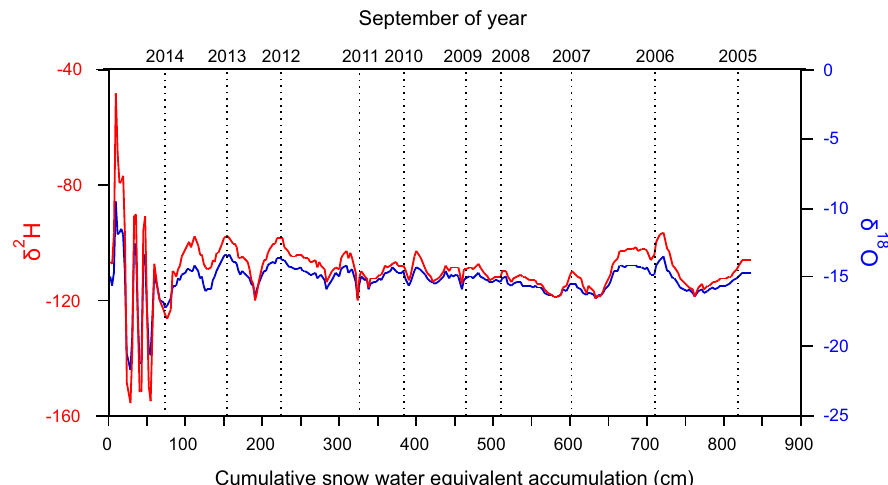
Figure 2. Holtedahlfonna firn core isotope and measured mass balance inferred dating. The red and blue curves present the hydrogen and oxygen isotope profiles for the firn core. The dashed lines indicate the September layers of the firn core against the firn depth in cumulative snow water equivalent centimetres. These data are based on snow accumulation rate (mass balance) measurement on a nearby stake. Please see text for more